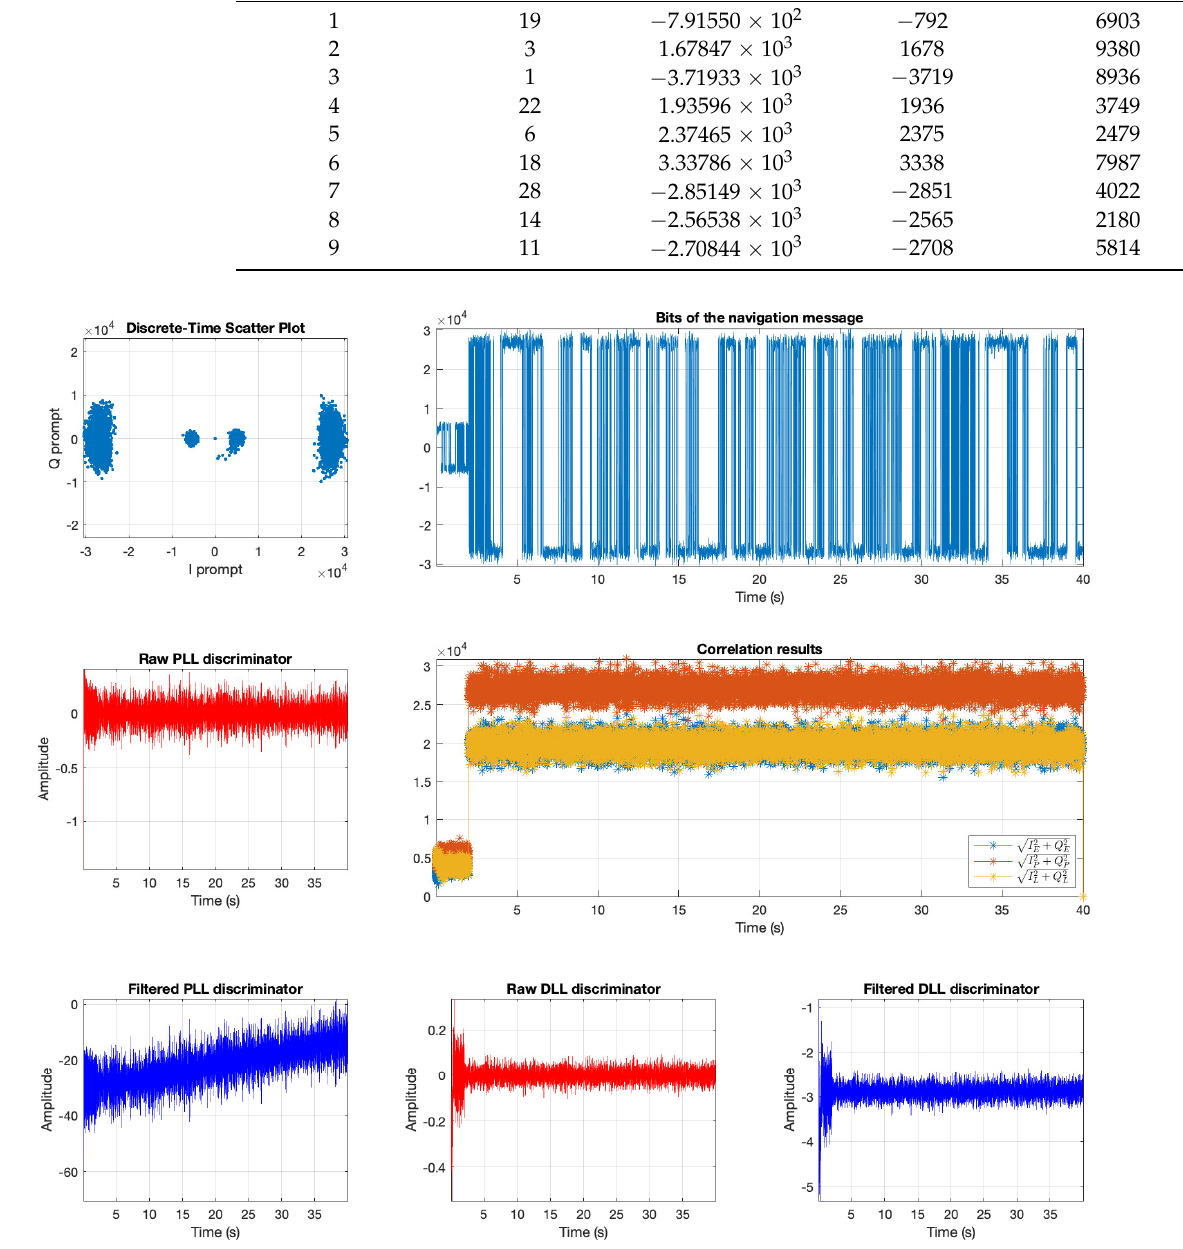
Figure 13. Tracking results of PRN